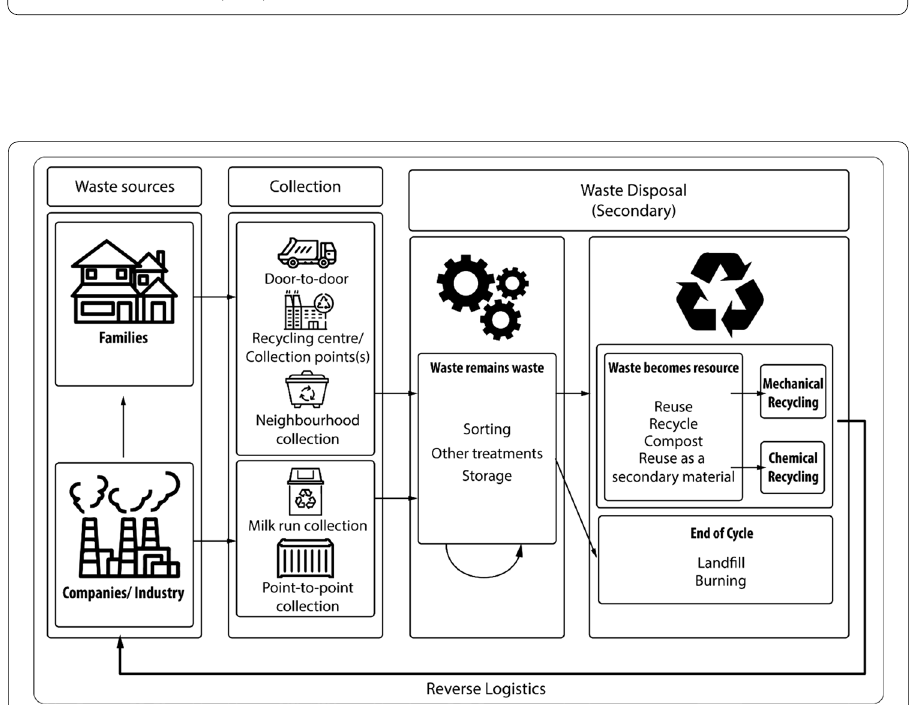
Fig. 3 Waste cycle. Source: Own